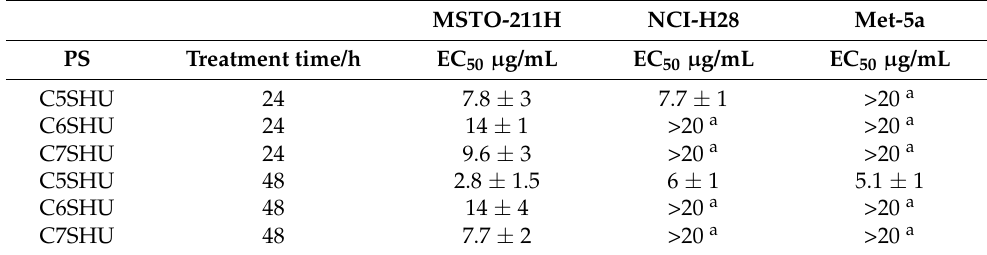
Figure 6. PS-induced cytotoxicity on Met-5a cells as determined by the WST-8 assay 24 and 48 h after PDT treatment. Cells received C5SHU, C6SHU and C7SHU treatments in dark and light conditions. Results are expressed as the mean ± SD of three independent experiments performed in triplicate. The varying significance of light treatments relative to the untreated control are indicated by * ( p ≤ 0.05), ** ( p ≤ 0.01), *** ( p ≤ 0.001) and **** ( p ≤ 0.0001). Table 1. Dose response, EC 50 values for PDT activity in the PS C5SHU, C6SHU, and C7SHU in the MSTO-211H, NCI-H28, and MET-5a cell lines at 24 and 48 h time points. EC 50 values are an average of three independent experiments, given in µ g/mL and errors are included at ±